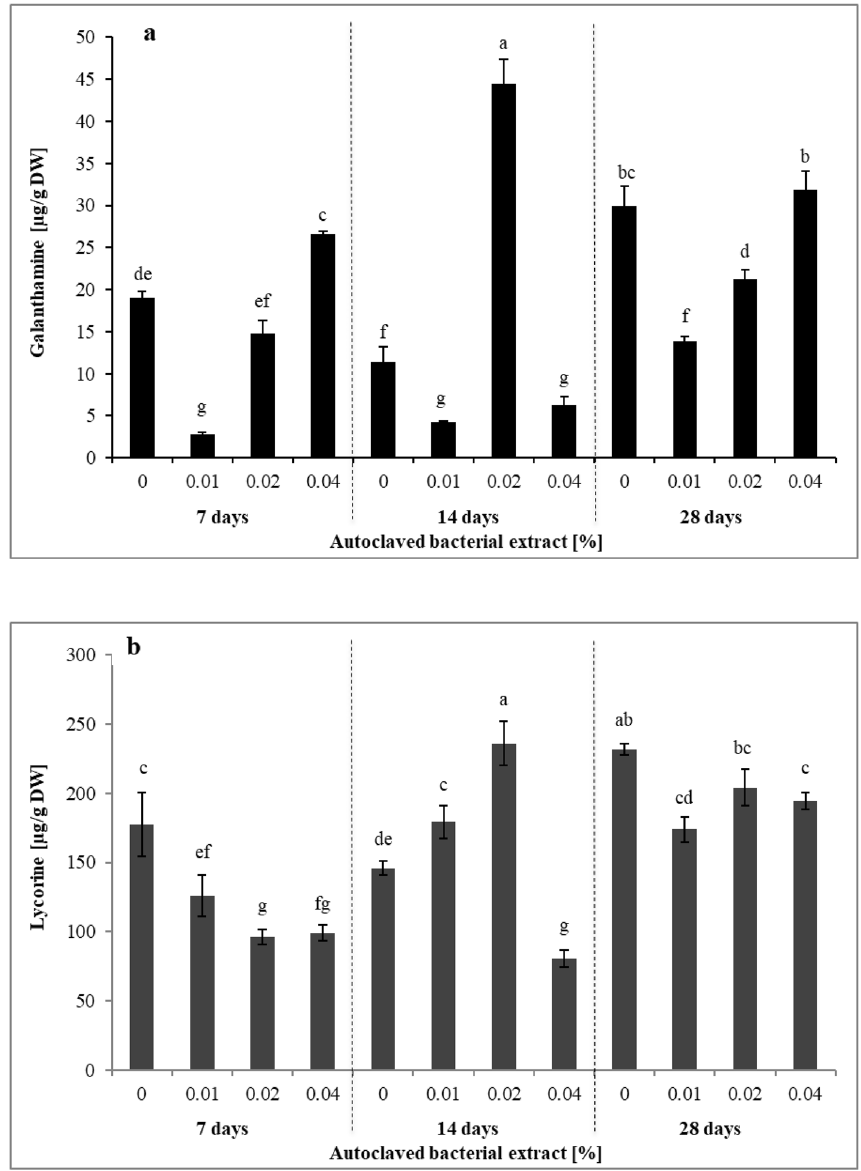
Figure 5. Effect of Paenibacillus lautus strain PLV elicitation on ( a ) galanthamine, ( b ) lycorine content in L. aestivum in vitro plants. The results are means of three replicates (n = 3) of analysis using LC–MS. Error bars represent ± SD. Different letters indicate a significance difference at P < 0.05 according to ANOVA and Duncan’s test. DW: dry